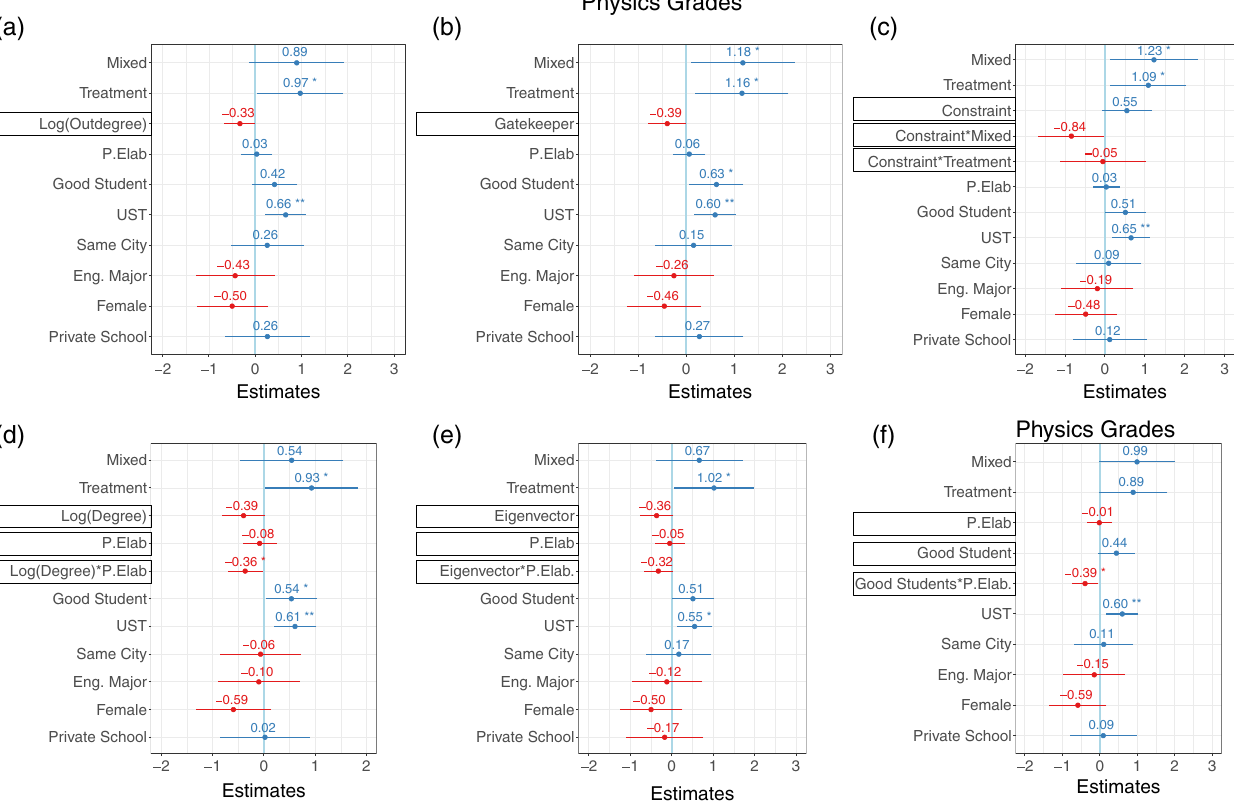
FIG. 4. Graphic depiction of OLS multiple regression models for physics grades regressed on network predictors, controlling for confounding variables (see Table 2 on the Supplemental Material [41] results section). Red indicates a negative effect and blue indicates a positive effect. One star (*) indicates significance at a level of p value < 0 . 05 and two stars (**) indicate significance at a level of p value < 0 . 01